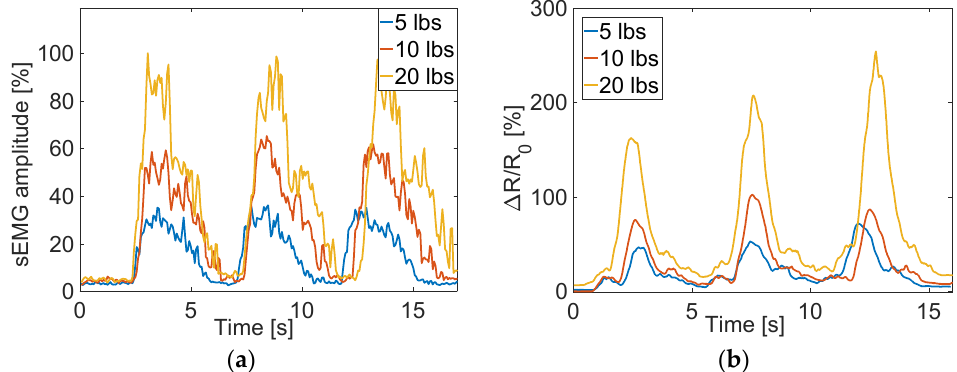
Figure 12. ( a ) The sEMG results showed greater muscle activation when heavier weights were lifted, and ( b ) the corresponding Motion Tape results exhibited the same trends.